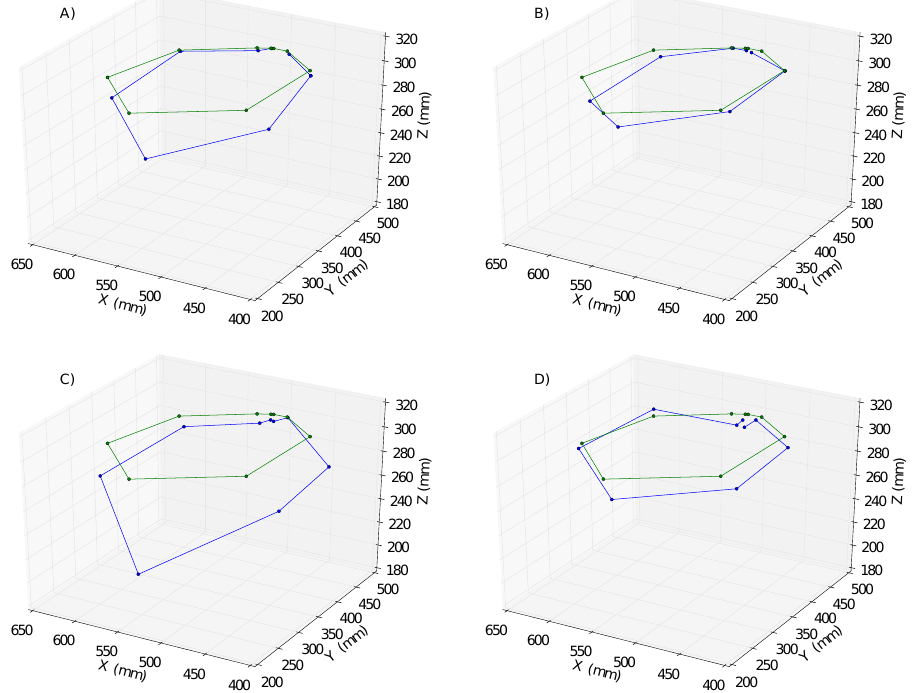
Figure 5. “Wax” Evolutionary Approximation results: The generalized trajectory is represented with the green trajectory, the blue trajectory is the executed one. The methods corresponding to each of the cases are the following: ( A ) SST; ( B ) PSO; ( C ) AFFG-PSO and ( D )